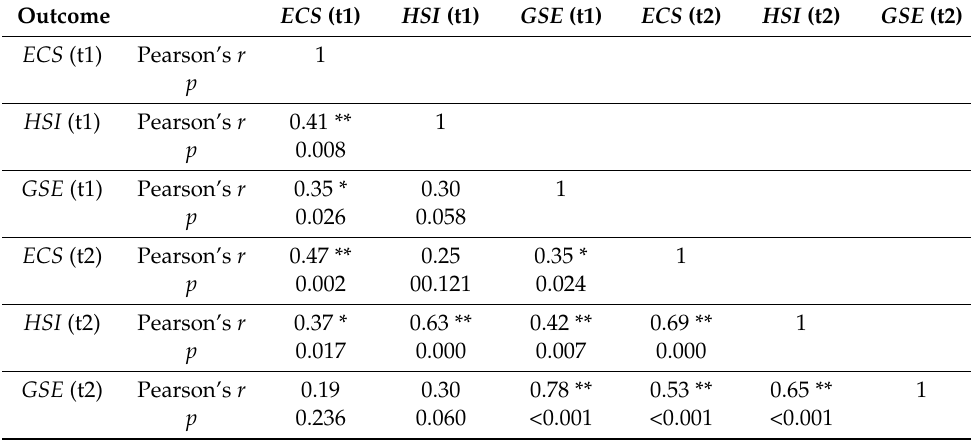
Table 3. Correlations of scales.